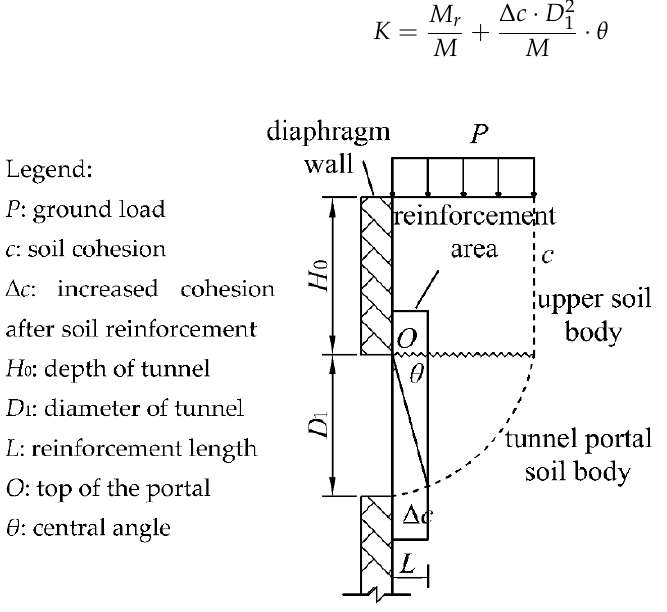
Figure 4. The stability calculation model of the tunnel portal with rectangular freezing soil mass.